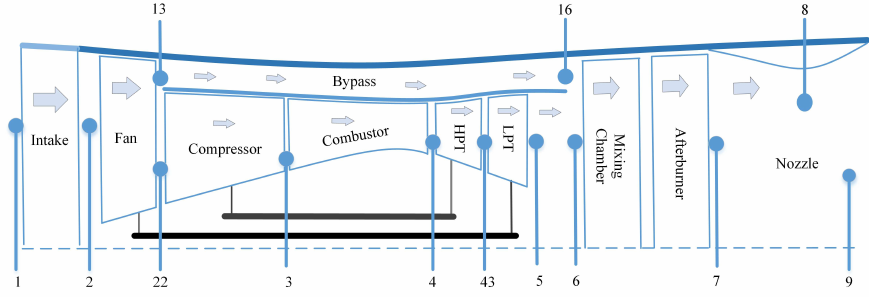
Figure 1. Structural diagram of the low-bypass turbofan